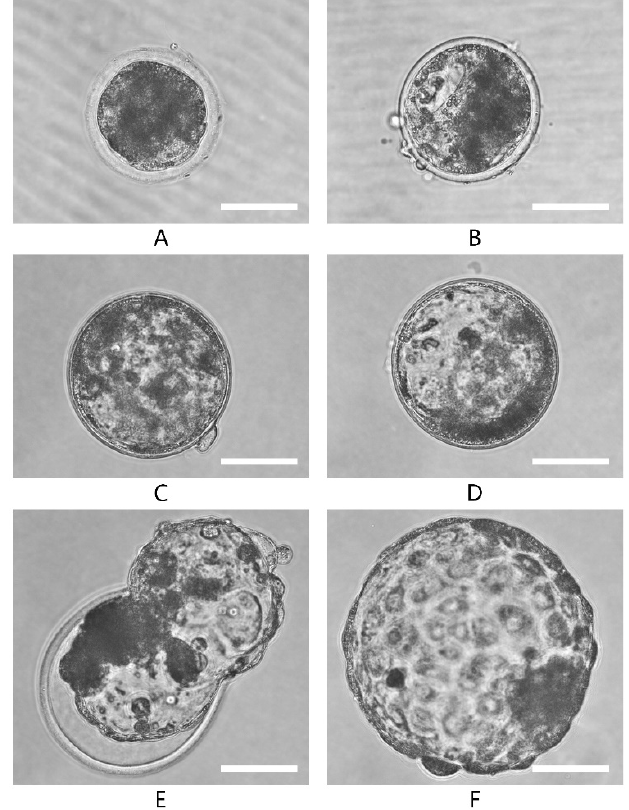
Figure 13. Embryo quality scoring based on expansion. Embryos were allotted scores of 1 ( A ), 2 ( B ), 3 ( C ), 4 ( D ), 5 ( E ) and 6 ( F ). The images were captured with microscope (50i; Nikon, Japan) at 200x resolution.